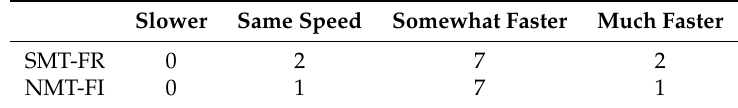
Table 4. Answers to the first question: When making use of MT suggestions, do you think you work slower/at the same speed/somewhat faster/much faster than without using MT? Slower Same Speed Somewhat Faster Much Faster